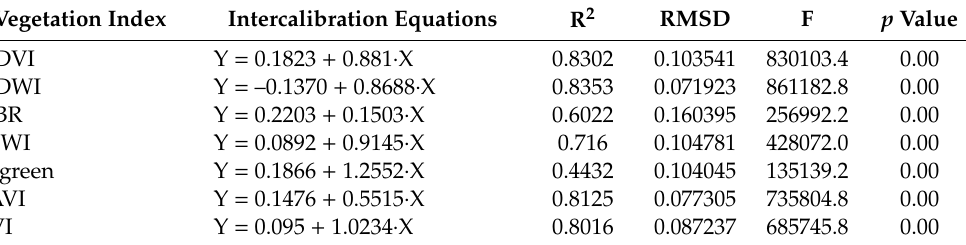
Table 7. Intercalibration equations between ETM + and OLI